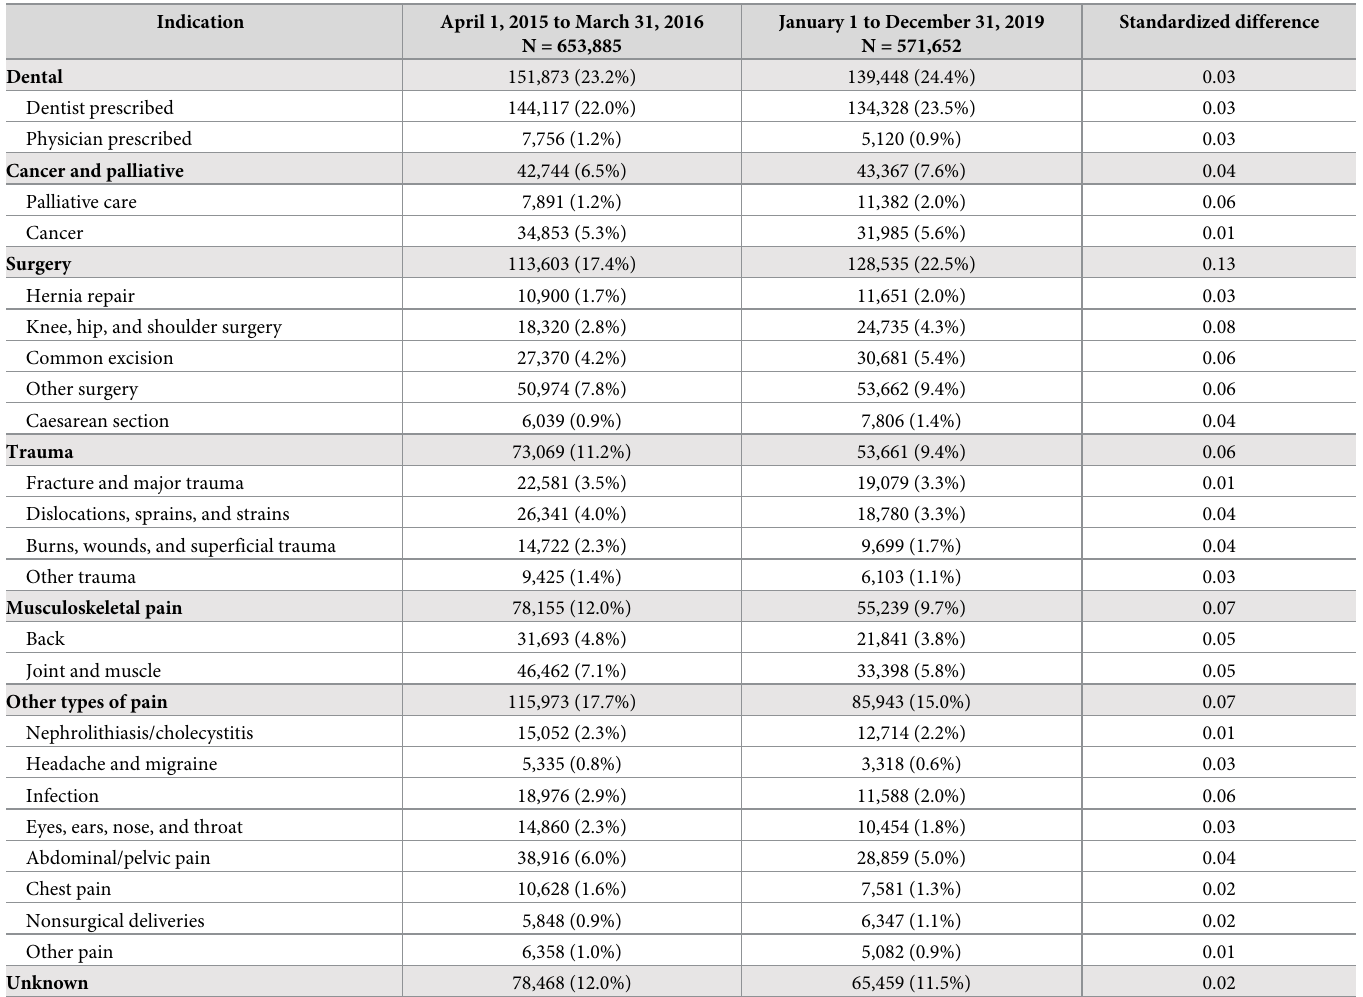
Table 2. Distribution of indications for opioid initiation in fiscal year 2015 and calendar year